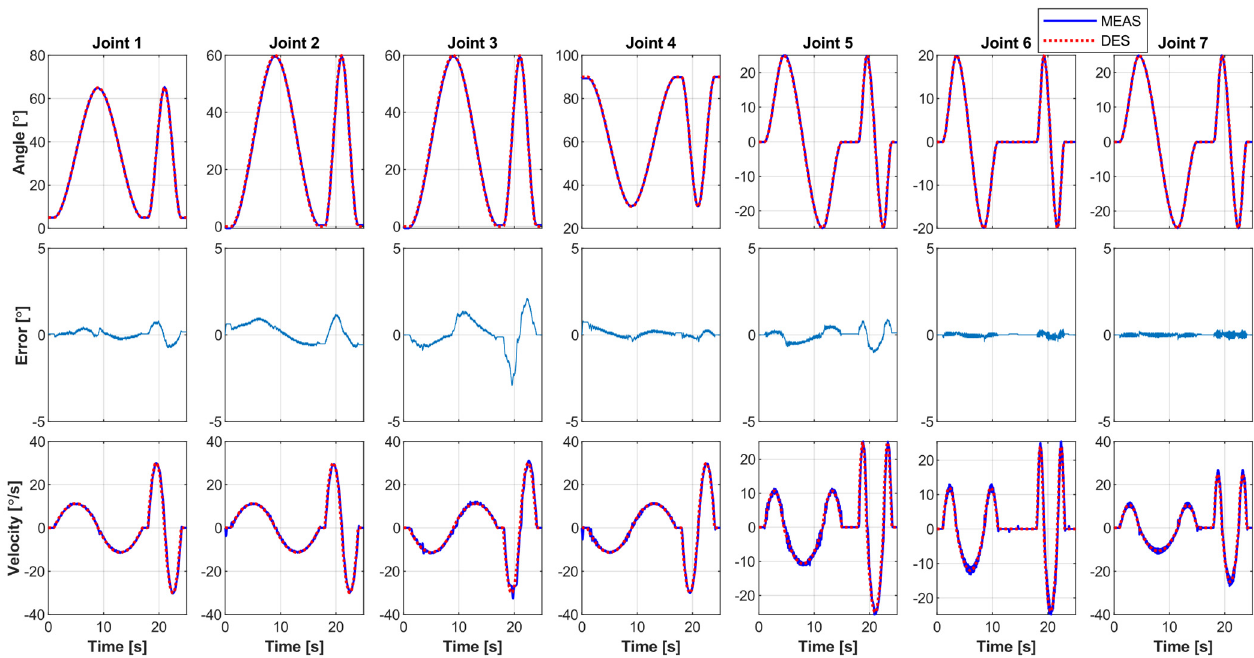
Figure 11. All seven joints’ passive exercise, while Subject D remains passive during the motion.